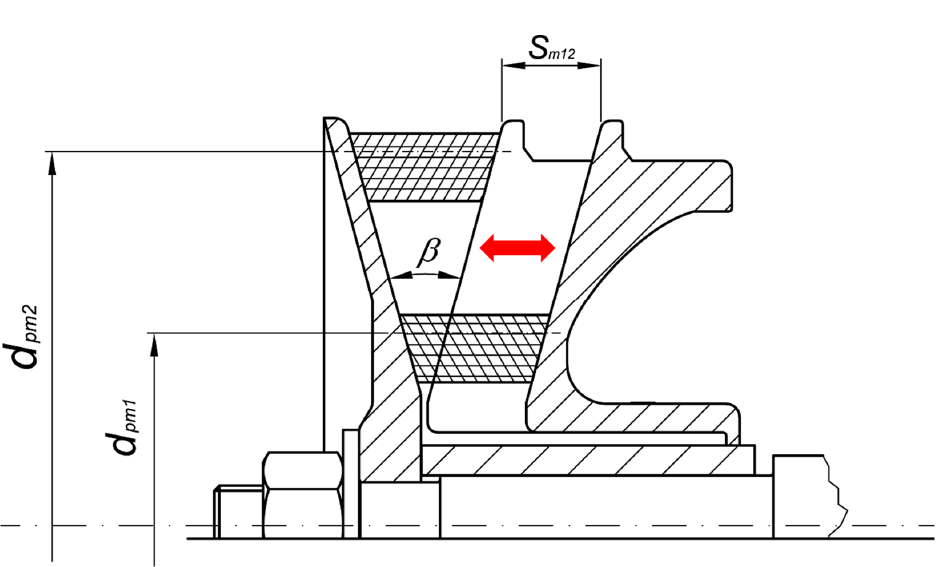
Figure 8. Axial displacement of the